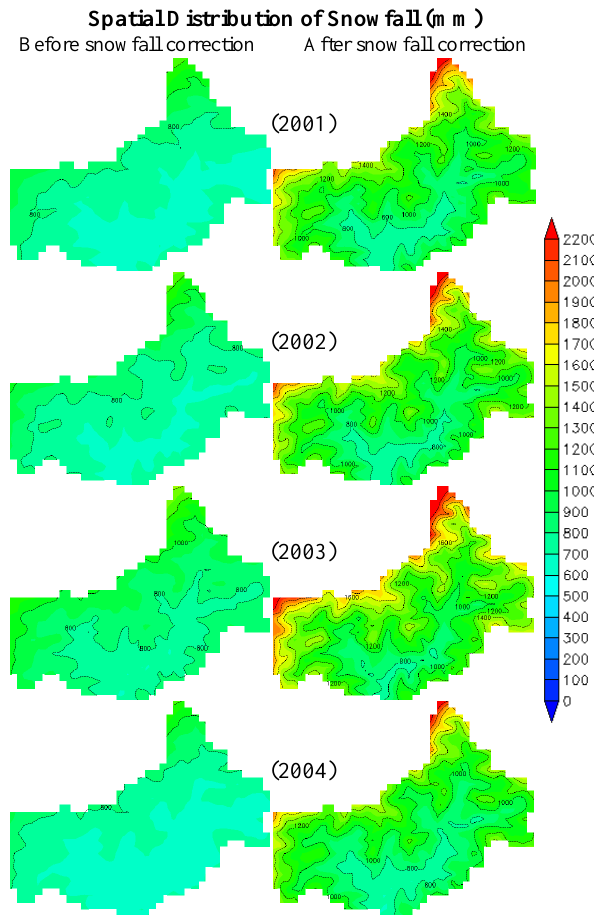
Fig. 7. Spatial distribution of snowfall before and after snowfall cor- rection, 2001–2004. Contour lines in the figure represents the value of